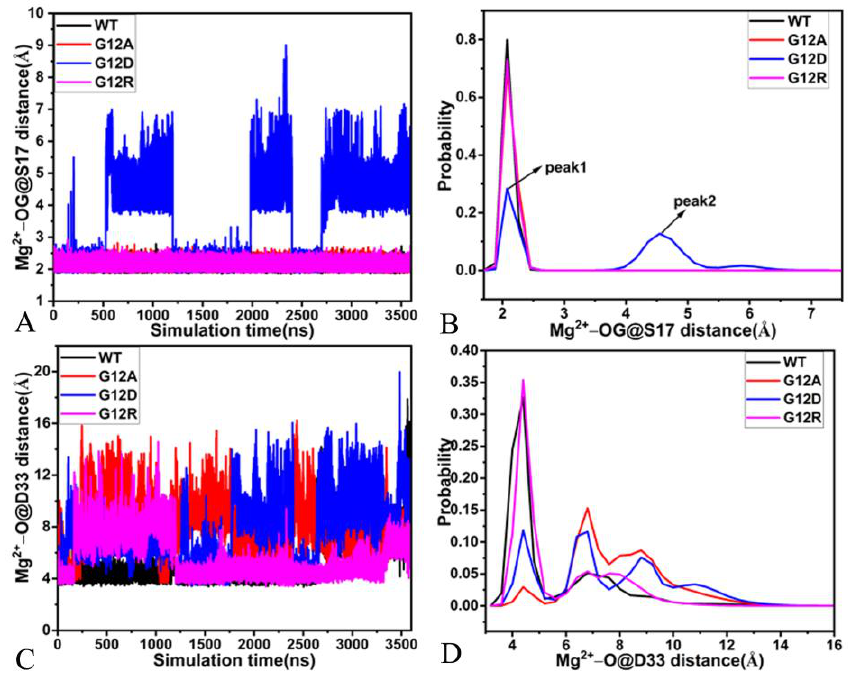
Figure 10. The time evolution and probability distributions of distances between magnesium ion and residues S17 and D33: ( A , B ) corresponding to the time evolution of the distance between magnesium ion and the oxygen atom OG of S17 and its probability distribution, respectively, and ( C , D ) corresponding to the time course of the distance between the magnesium ion and the oxygen atom O of D33 and its probability distributions, individually.